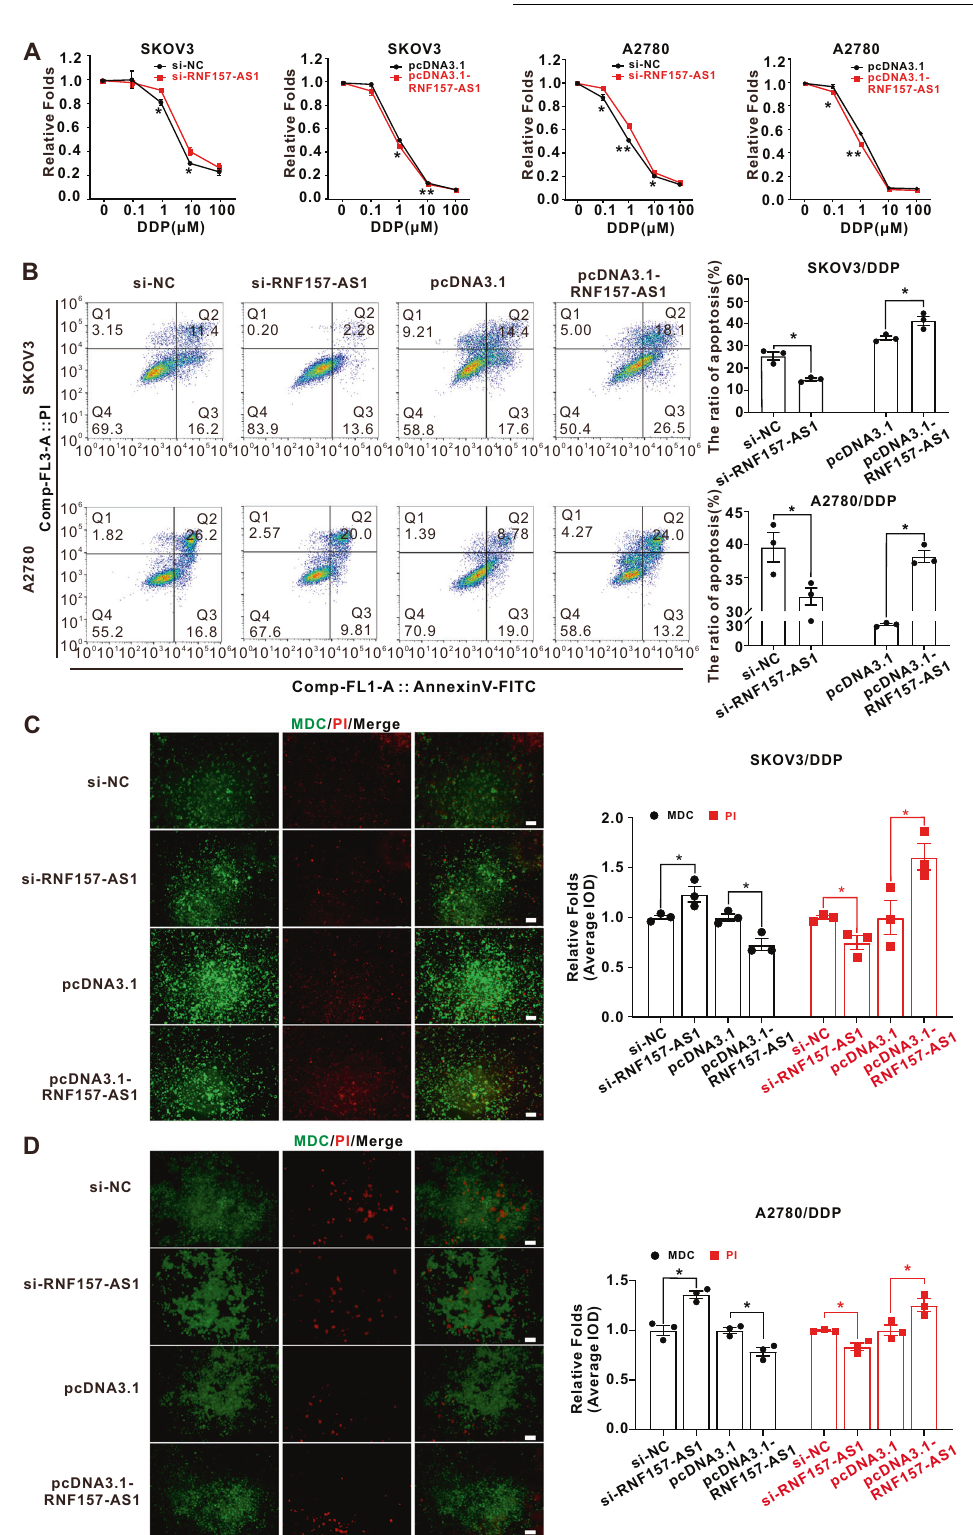
Fig. 7 RNF157-AS1 reduced the viability and promoted the apoptosis of EOC cells under a DDP environment. A Treatment with DDP (2 μ M) for 48 h, RNF157-AS1 overexpression signi fi cantly reduced SKOV3 and A2780 cell viability but RNF157-AS1 depletion enhanced EOC cell viability. B Treatment with DDP (2 μ M) for 48 h, RNF157-AS1 interference markedly reduced the apoptosis rate of SKOV3 and A2780 cells and RNF157-AS1 overexpression increased the apoptosis rate of EOC cells. C and D Under the DDP environment, RNF157-AS1 depletion increased MDC staining and decreased IP staining. on the contrary, RNF157-AS1 overexpression elevated MDC staining and diminished IP staining. The bar represents 100 μ m. Data were obtained from at least three independent experiments. * P < 0.05; ** P < 0.01 ( t -test).